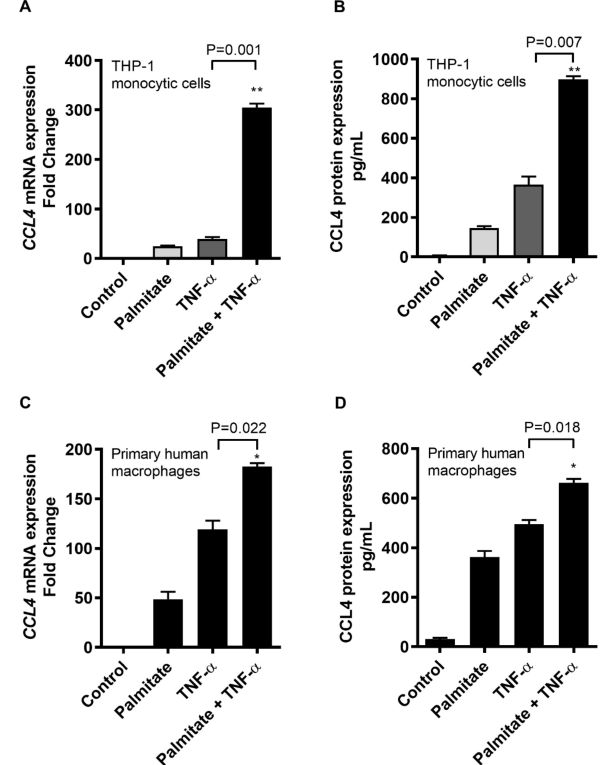
Figure 1. Palmitate and TNF- α cooperatively induce the CCL4 expression in human monocytic cells and primary macrophages. THP-1 monocytic cells and primary human macrophages were co-stimulated with palmitate and TNF- α following procedures as described in the materials and methods section, while each of the individual stimulations with vehicle, palmitate or TNF- α served as control. The data (shown as mean ± SEM) indicate that ( A ) CCL4 mRNA expression ( p = 0.001) and ( B ) CCL4 secreted protein expression ( p = 0.007) were highly promoted as THP-1 human monocytic cells were co-stimulated with TNF- α / palmitate compared to individual stimulations. Similarly, co-stimulation of primary human macrophages with TNF- α / palmitate also triggered the expression of ( C ) CCL4 mRNA ( p = 0.022) and ( D ) CCL4 protein ( p = 0.018) compared to individual stimulations. * Significant ( p < 0.02), ** Very significant ( p <